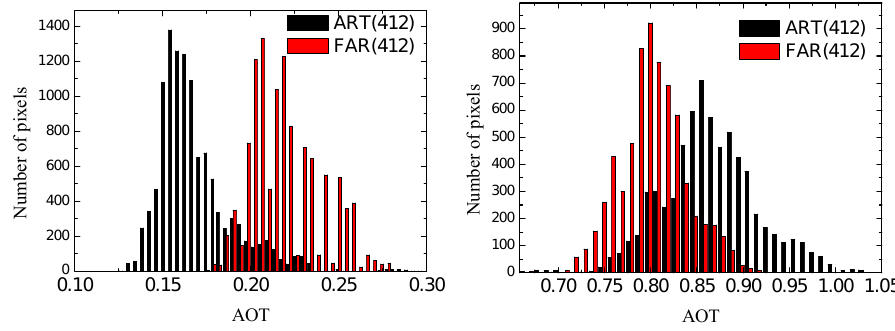
Fig. 14. Histograms of the distributions of the AOT at the wavelength 412.5nm retrieved with the FAR and ART codes from MERIS on ENVISAT data for the areas marked in Fig. 10.